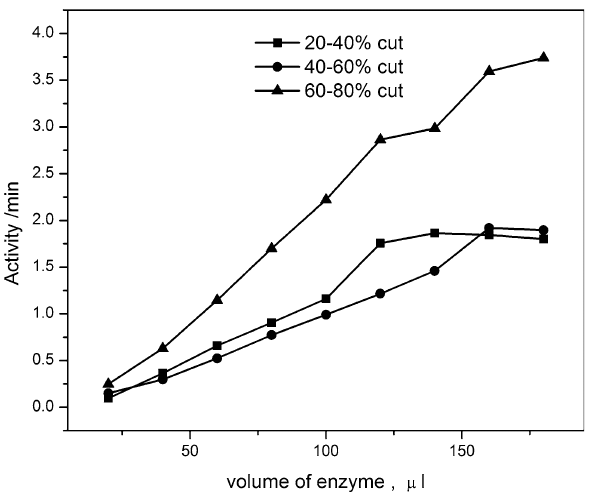
Fig. 3 Optimization of cuts and enzyme volume for baby corn silk